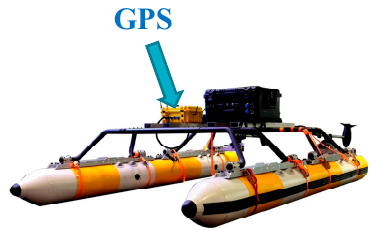
Figure 3. Installation of the GPS antenna.